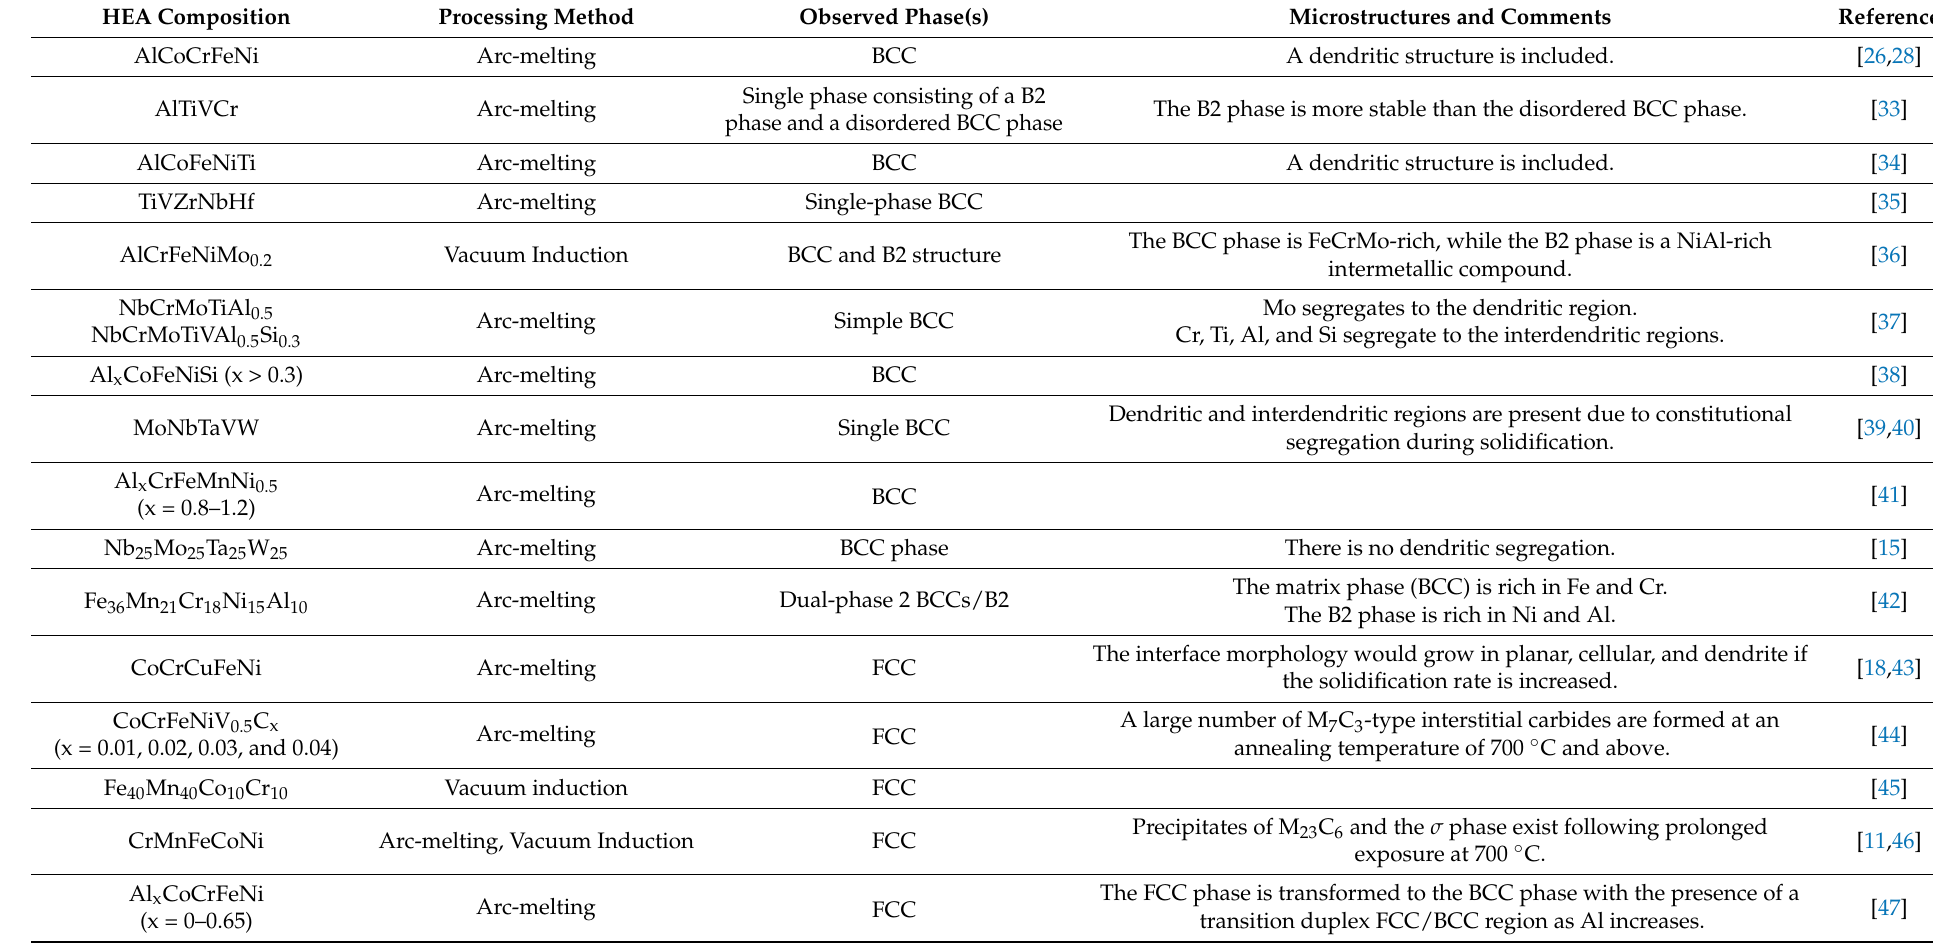
Table 1. Phase evolution of HEAs fabricated using the melting and casting